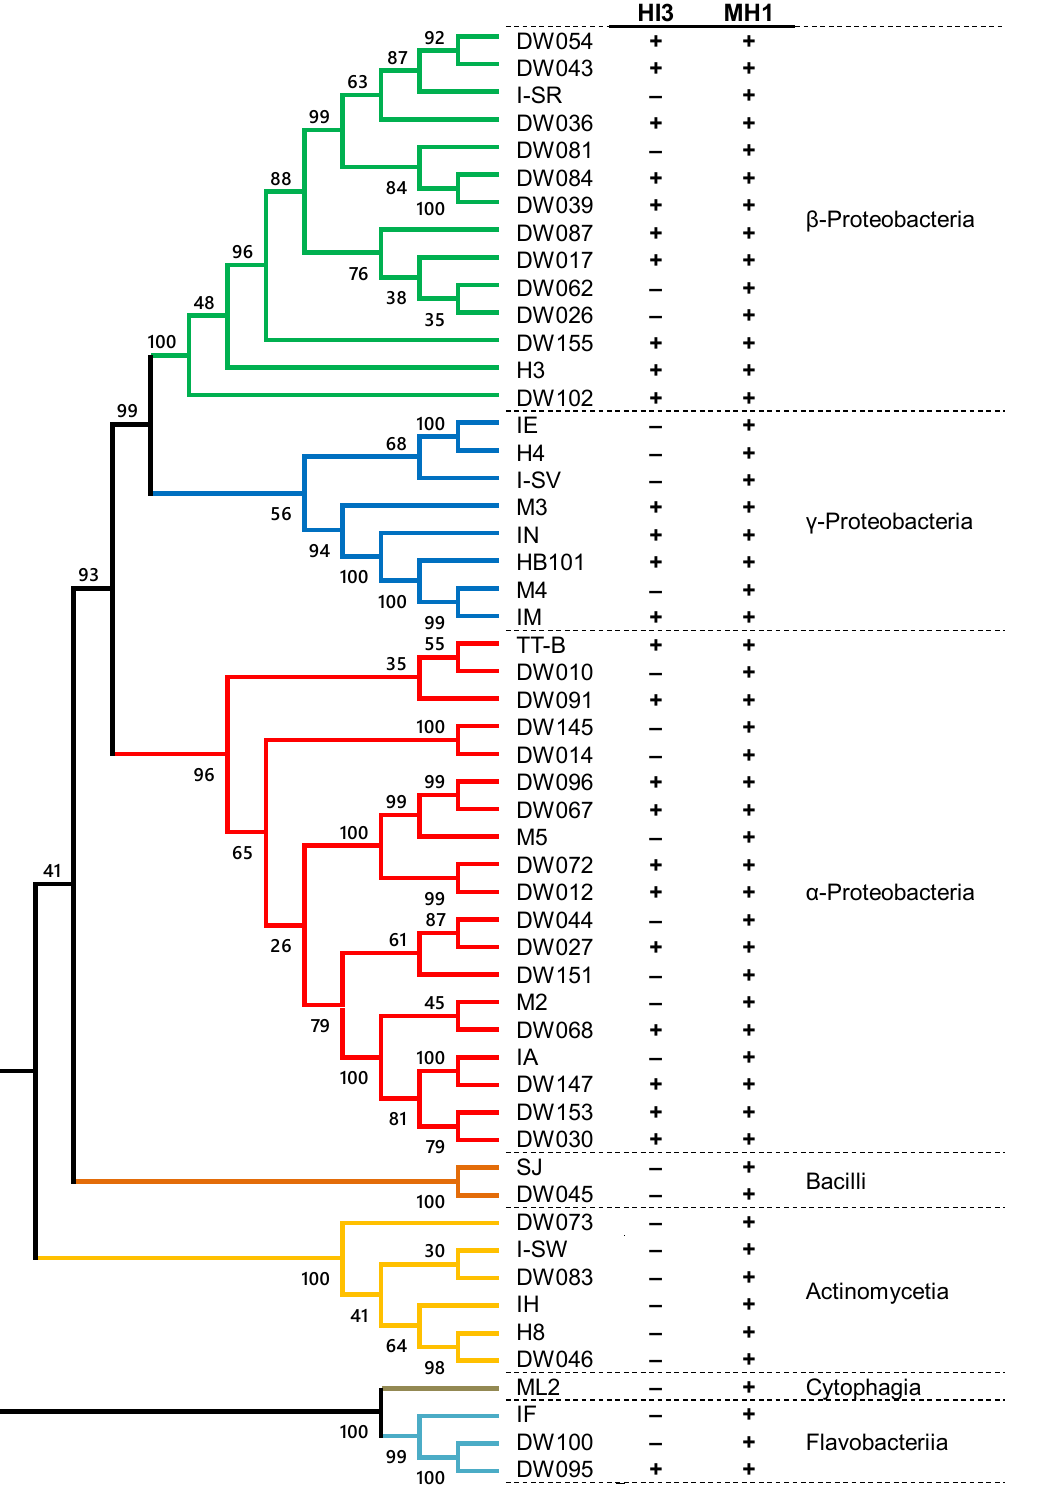
Figure 2. Prey range specificities of Bacteriovorax stolpii HI3 and Myxococcus sp. MH1 on 53 potential prey strains. Detailed phylogenetic information of potential prey strains is provided in Table S1. +, predation; − , no predation.